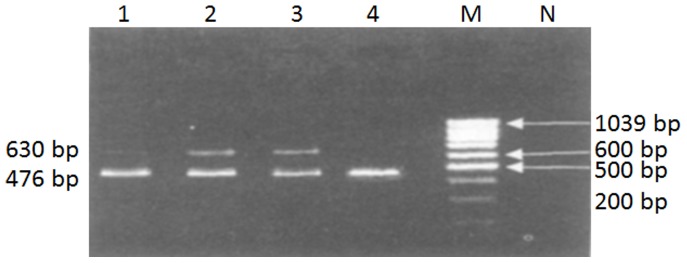
PCR result of myocardial mtDNA in VMC mice.Lane 1: myocardial mtDNA of 3 days after viral injection; lane 2: myocardial mtDNA of 11 days after viral injection; lane 3: myocardial mtDNA of 24 days after viral injection; lane 4: myocardial mtDNA of control mouse. M: DNA marker; N: negative control.